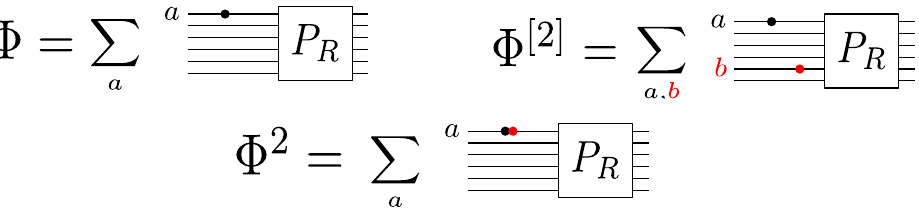
Figure 2. Single-particle insertions and two-particle insertions on the higher-rank Wilson loop. The Wilson loop in the higher-rank representation can be thought of as a collection of fundamental Wilson loops (black straight lines in the figure) joined together by a projector (denoted by P R in the figure). In this representation, the insertion of a single scalar Φ is a sum over insertions of Φ (denoted by a dot) on each fundamental loop. To insert two Φ’s, there are two possibilities: the first possibility is to simply consider a product of two Φ’s and is given by a double sum Φ [2] . The other possibility is to insert Φ 2 to each fundamental loop. The former operator (Φ [2] ) is a two-particle operator while the latter (Φ 2 ) is a single-particle